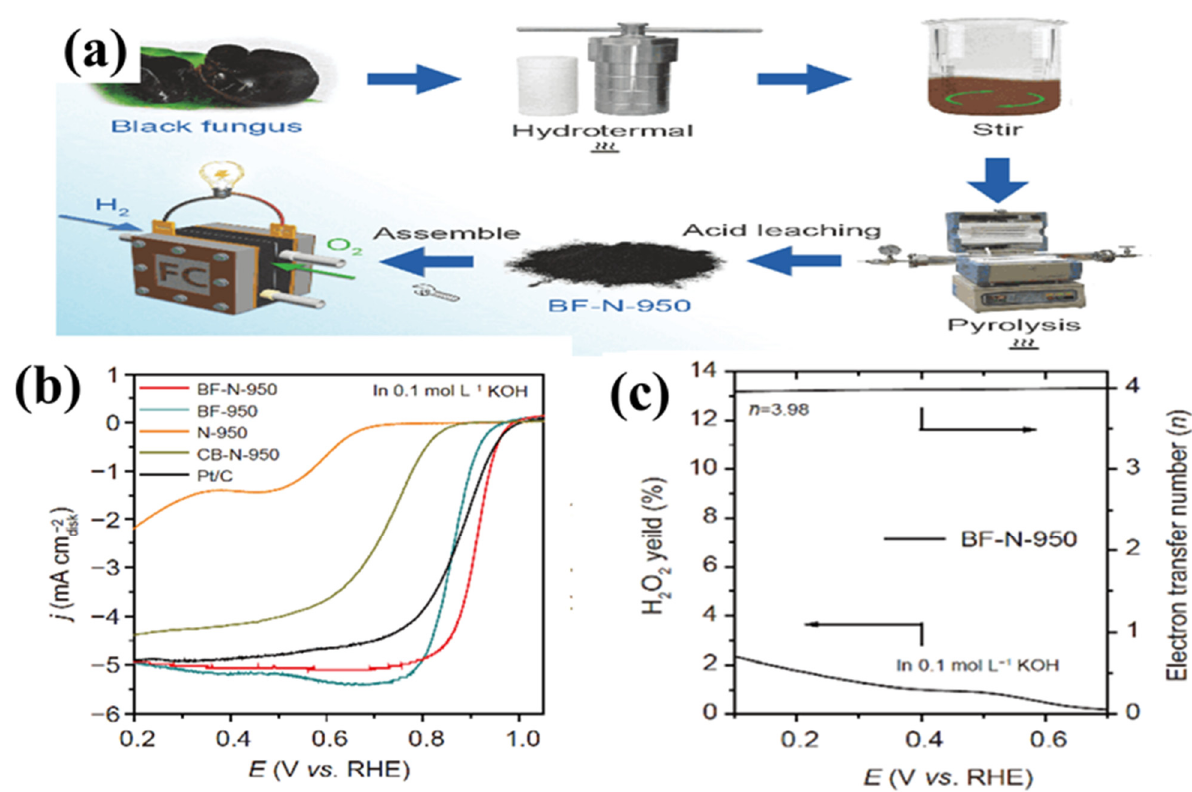
Figure 13. ( a ) Schematic illustration for the synthesis of BF–N–950 and fabrication of a PEMFC, ( b ) linear sweep voltammetry (LSV) polarization curves of the catalysts tested in O 2 –saturated 0.1 mol L –1 KOH at a scan rate of 1 mV s –1 , ( c ) electron transfer number of the BF–N–950 in 0.1 M KOH, adapted from [86].